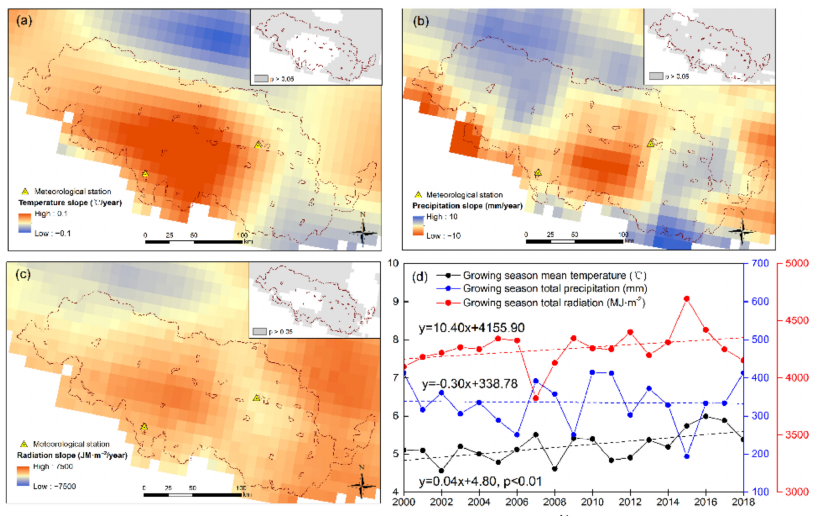
Figure 6. Spatial distributions of variations in climate data (CMFD product) in the QNNP (2000–2018): ( a ) temperature; ( b ) precipitation; ( c ) radiation. ( d ) Variation in the regional mean climatic factors during